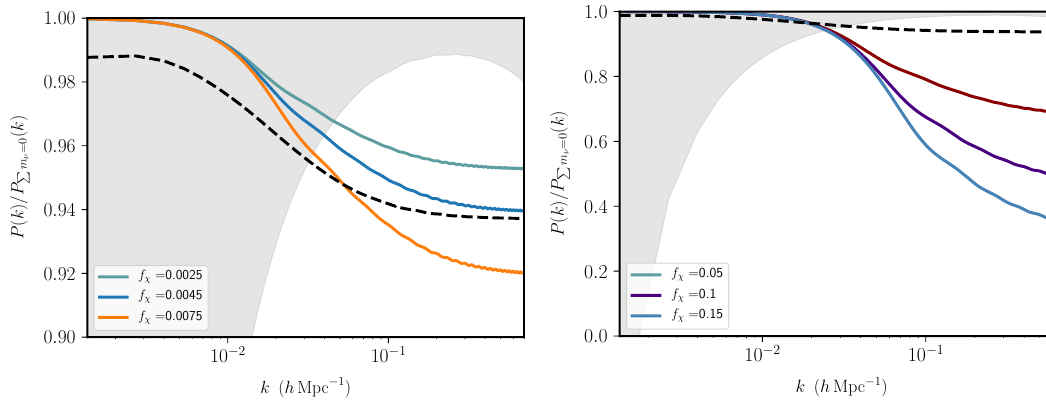
Figure 2 . Suppression of power due to neutrino interactions with a dark matter sub-component that makes up a fraction f χ = ρ χ /ρ m of the total matter density for P m ν = 58 meV. The black dashed line indicates the case of P m ν = 120 meV (with no coupling to dark matter) for reference. The grey bands indicate the 1 σ error of a BOSS-like galaxy survey [56] from the combination of cosmic variance and shot noise, which dominate at low and high k respectively. Left: showing small fraction of dark matter, we conclude that f χ < 0 . 005 is a conservative limit based on current constraints. Right: for larger fractions of the total energy density, we see that the suppression would be easily excluded by current